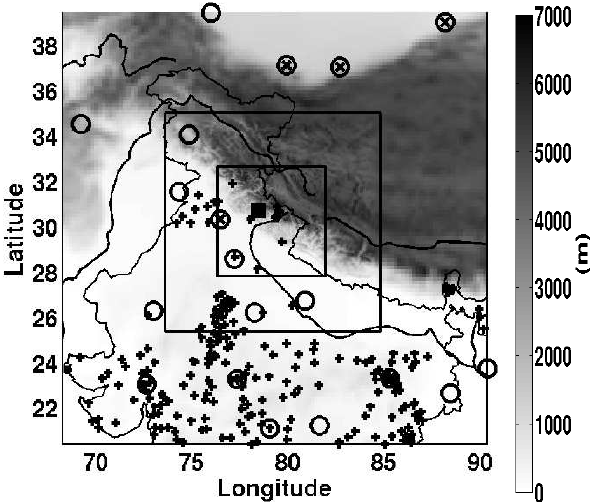
Figure 1. Terrain for simulation of the cloudburst over Uttarkashi. The three boxes are the three nested domains. Notice that the res- olution of the topography increases towards the inner domain. The filled square denotes the location of where cloudburst had occurred, circles denote the location of the sounding stations, crosses denote the locations of the sounding stations for which the soundings are plotted, and plus symbols show the locations of the AWS stations against which the surface simulations are